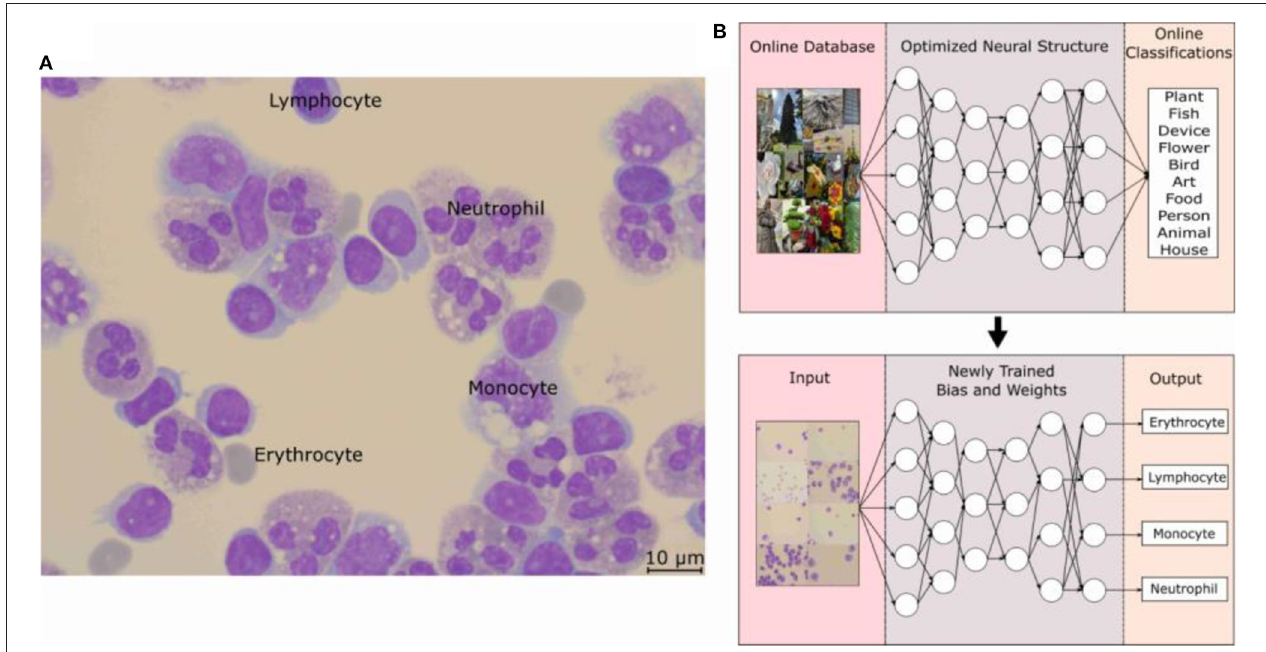
FIGURE 1 | (A) Optical microscope image taken at 100 × with a scale bar of 10 µ m. Cells were fixed and stained with MGG, which provides a light color to the cytoplasm of the cell and purple color to the lobes of the nucleus. Labels for the three WBCs and the RBCs can be seen in the picture. (B) Schematic of how the object-detection DNN model is trained to form its basic architecture. The model structure is Faster R-CNN with an initial learning rate of 0.001, a batch size of 4, and an IOU threshold of 0.5. The structure along with an online database was used to train the DNN model and then with the basic architecture, the weights and biases are optimized for the MGG-stained cell images of each classification. MGG, The May-Grünwald-Giemsa; DNN, deep neural network; RBC, red blood count; WBC, white blood